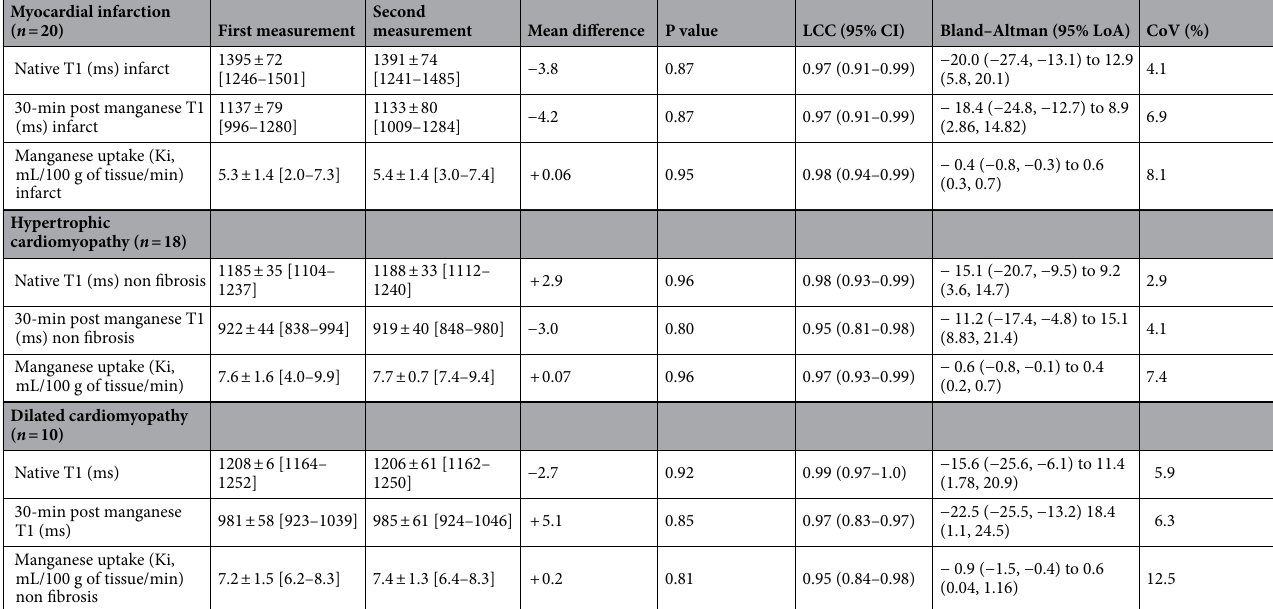
Table 2. Intra-observer repeatability for patients with myocardial infarction (infarct), hypertrophic cardiomyopathy (non-fibrosis) or dilated cardiomyopathy. Mean ± standard deviation [95% confidence interval]. LCC Lin’s concordance correlation, LoA limits of agreement, CoV coefficient of variation.